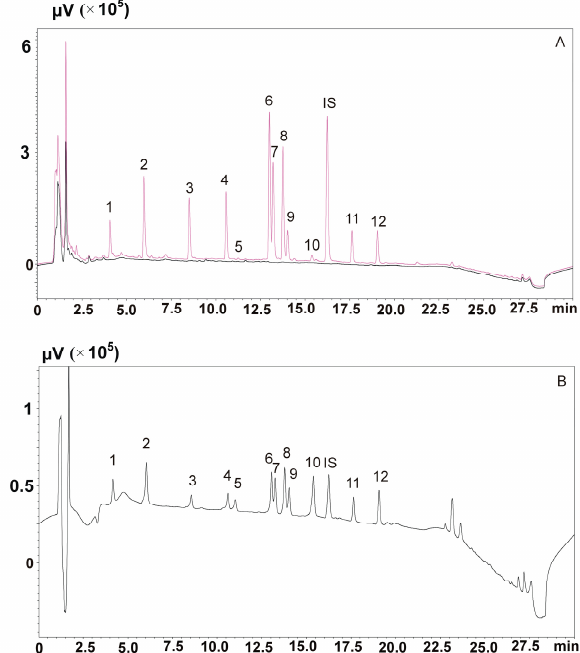
Figure 4. Chromatograms of a mixture of solutions of neuroleptics, carbamazepine and their metabolites. ( A )—saliva extract spiked with a mixture of analytes (100 ng/mL), obtained with the use of Strata X-C columns and the procedure 25. ( B )—mixtures of standard solutions (20 ng/mL):